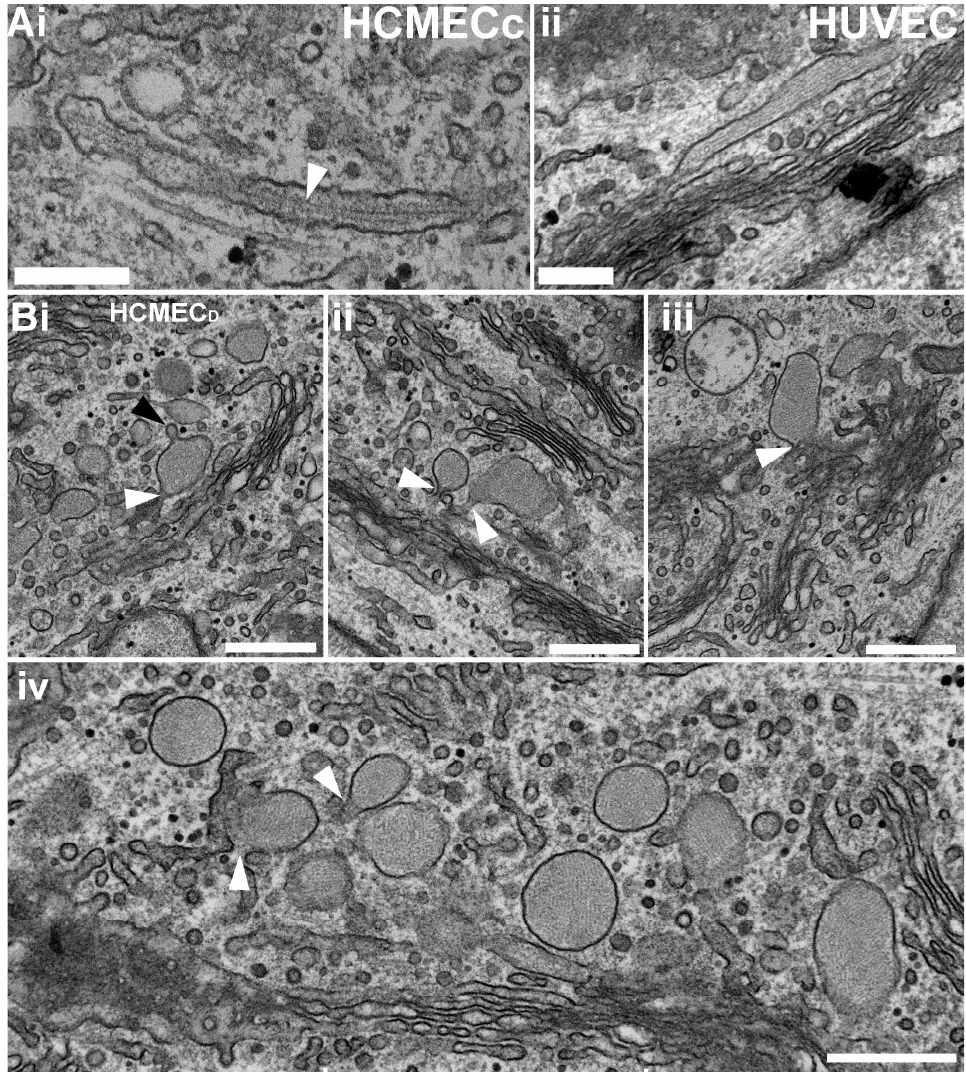
Figure 4. Rounded WPBs in HCMEC D form at the trans-Golgi network. ( Ai , ii ) En-face thin section transmission electron micrographs (TEMs) of HCMEC C ( Ai ) and HUVEC ( Aii ) showing mature WPBs with the typical rod-like shape and internal tubules (arrow in ( Ai )) and striations ( Aii ). ( Bi – iv ) Examples of en-face thin section TEMs of HCMEC D showing rounded WPBs connected (arrows) to a reticular network of Golgi membrane stacks. Scale bars: 250 nm. HCMEC; human cardiac microvascular endothelial cells ( C ; control, D ; dilated cardiomyopathy). WPBs; Weibel–Palade bodies. TEM; transmission electron microscopy.